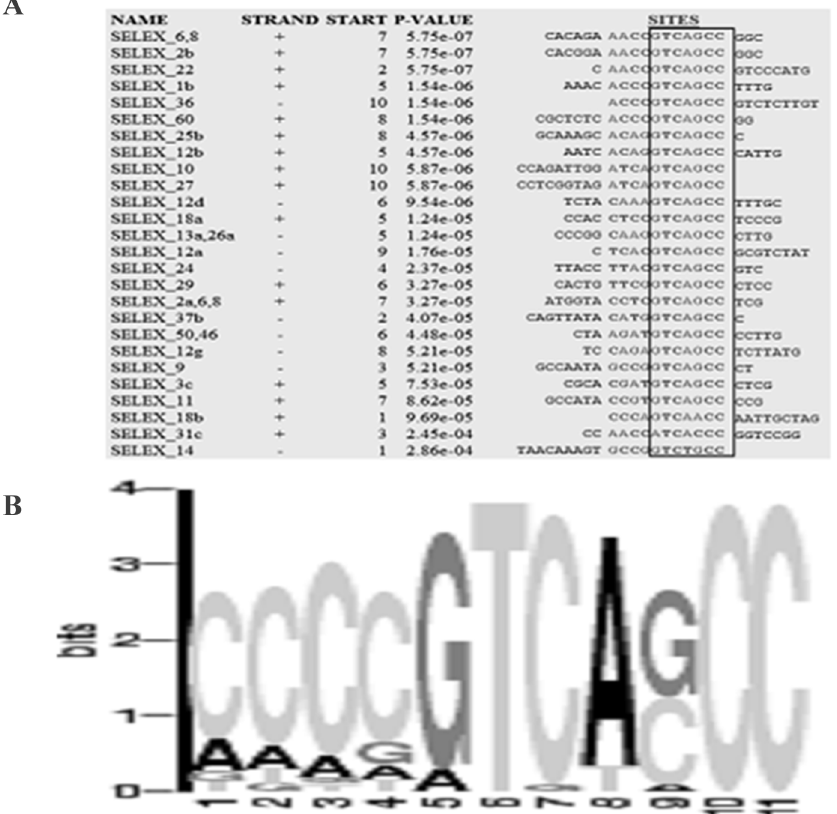
Fig 1. MEME-based prediction of INO80 binding motif. (A) Snapshot of MEME output for the sequences enriched after DBINO interaction, (B) Position weight matrix of the putative INO80 motif generated by MEME.